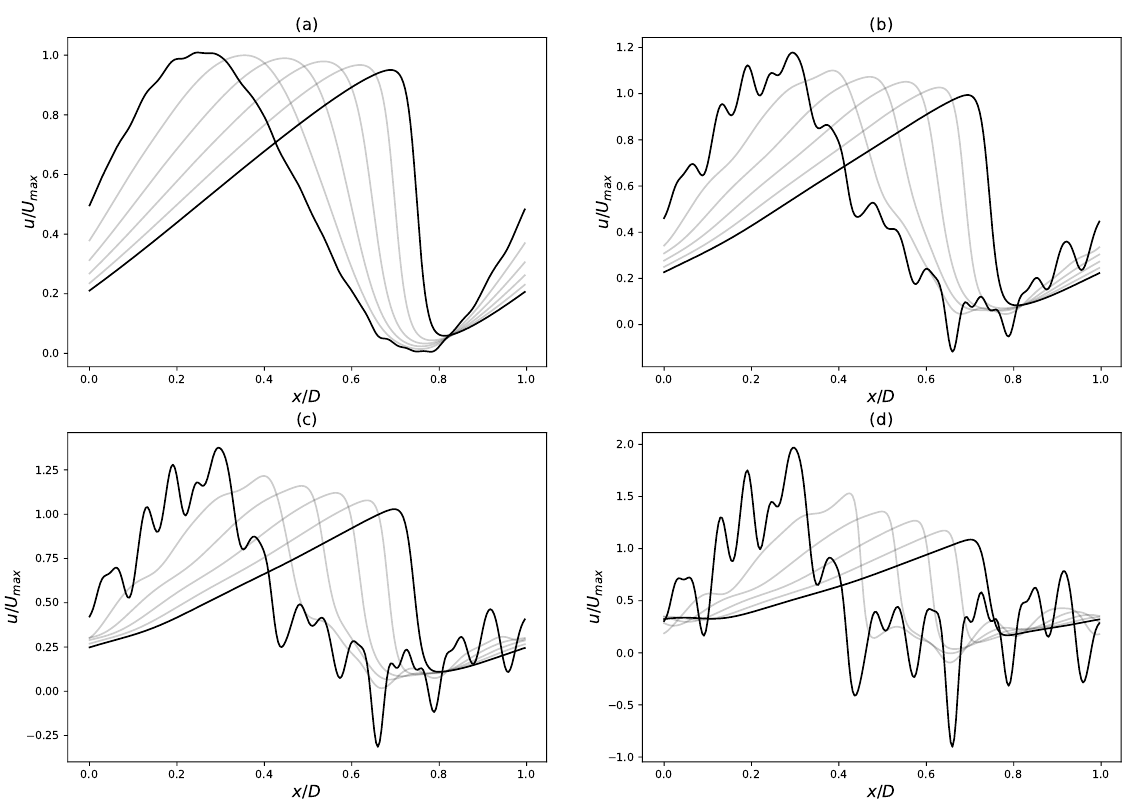
Figure 2. Solutions from the initial perturbations of magnitude (a) σ 0 { 0 , 0 . 2 , 0 . 4 , 0 . 6 , 0 . 8 , 1 } T .